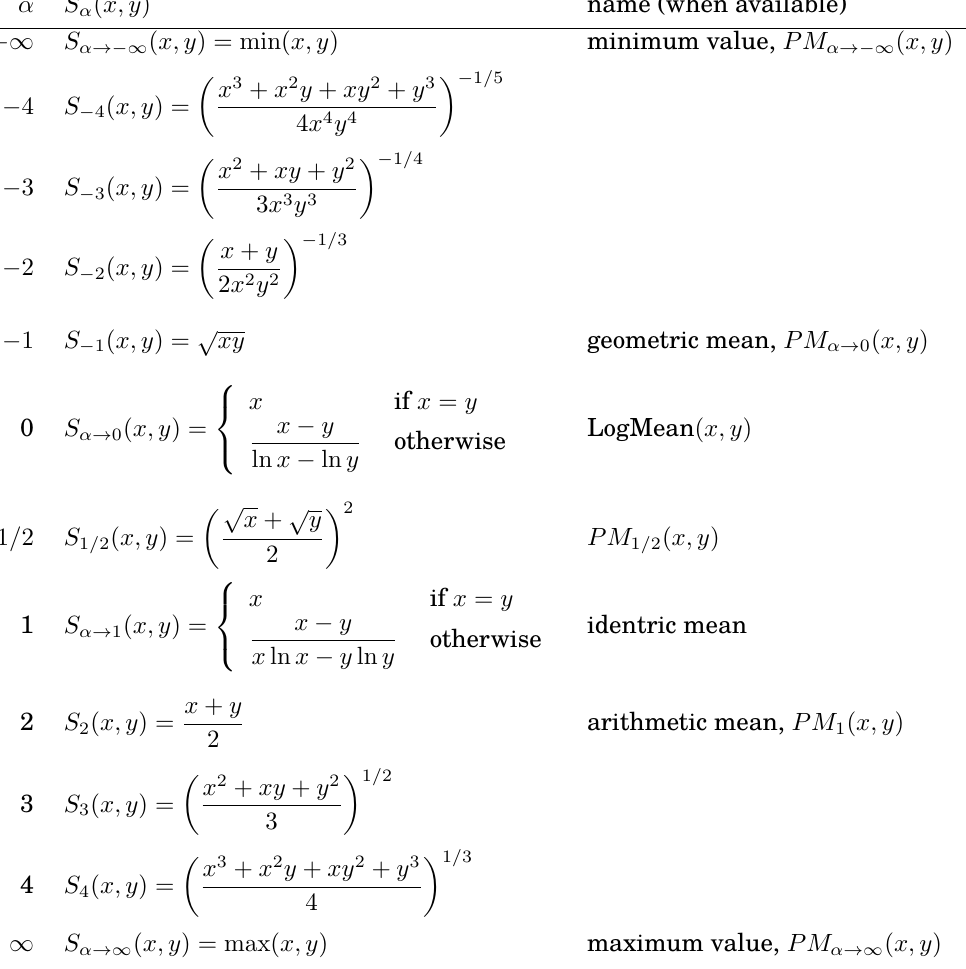
Table 1: Expressions for the Stolarsky mean S α S α ( x, y ) name (when